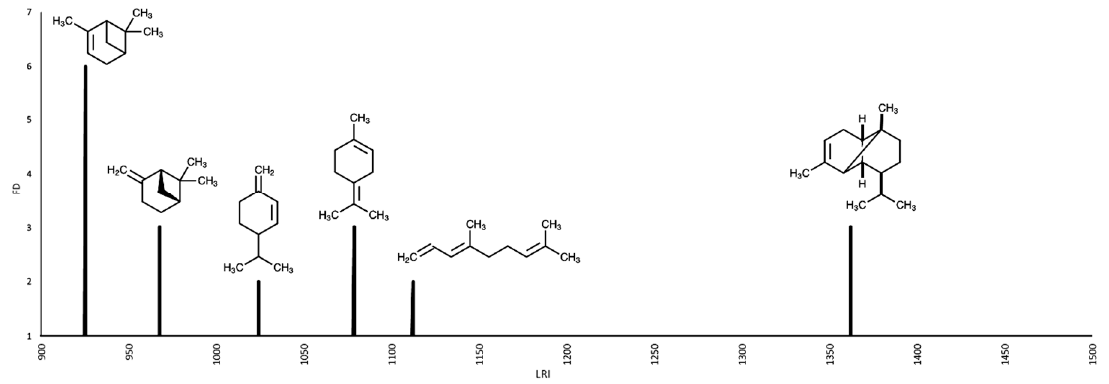
Figure 1. Superposition of the gas chromatogram and the aromagram of the essential oil.